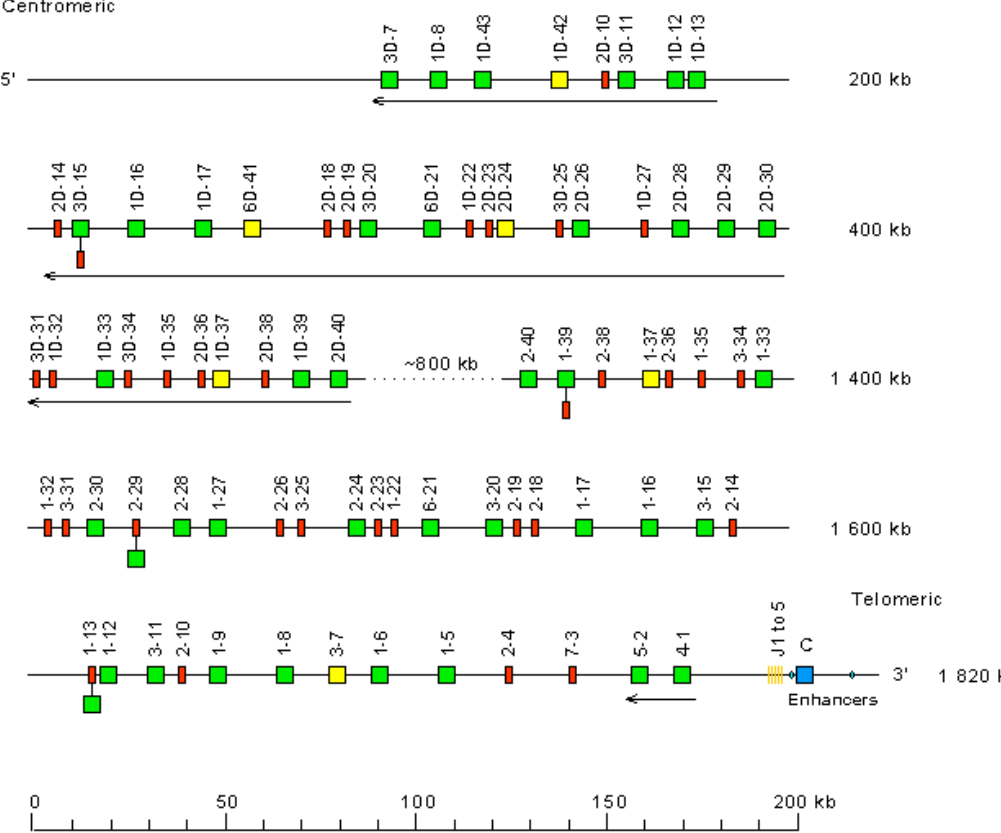
Figure 18. Representation of the human IGK locus at 2p12 [2]. The boxes representing the genes are not to scale. Exons are not shown. The IGKV genes of the proximal V ‐ CLUSTER are designated by a number for the subgroup, followed by a hyphen and a number for the localization from 3 ′ to 5 ′ in the locus. The IGKV genes of the distal duplicated V ‐ CLUSTER are designated by the same numbers as the corresponding genes in the proximal V ‐ CLUSTER, with the letter D added. Arrows show the IGKV genes polarity of which is opposite to that of the J ‐ C ‐ CLUSTER [2]. (With permission from M ‐ P. Lefranc and G. Lefranc, LIGM, Founders and Authors of IMGT ® , the international ImMunoGeneTics information system ® , http://www.imgt.org).